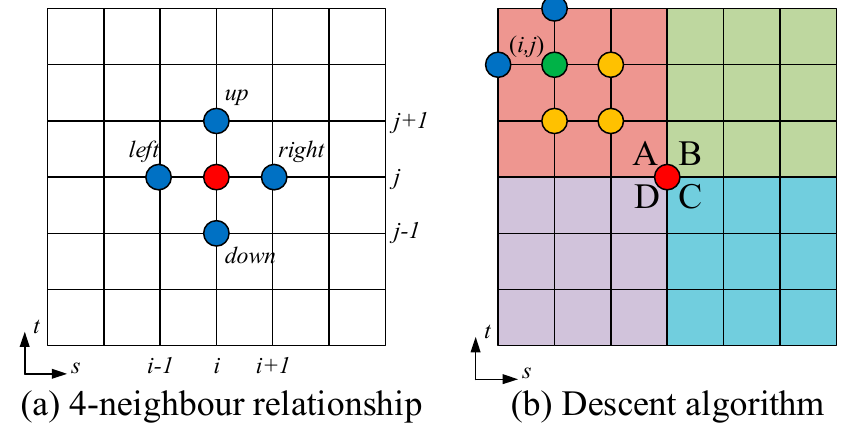
Figure 4. Feature recognition using watershed technology.